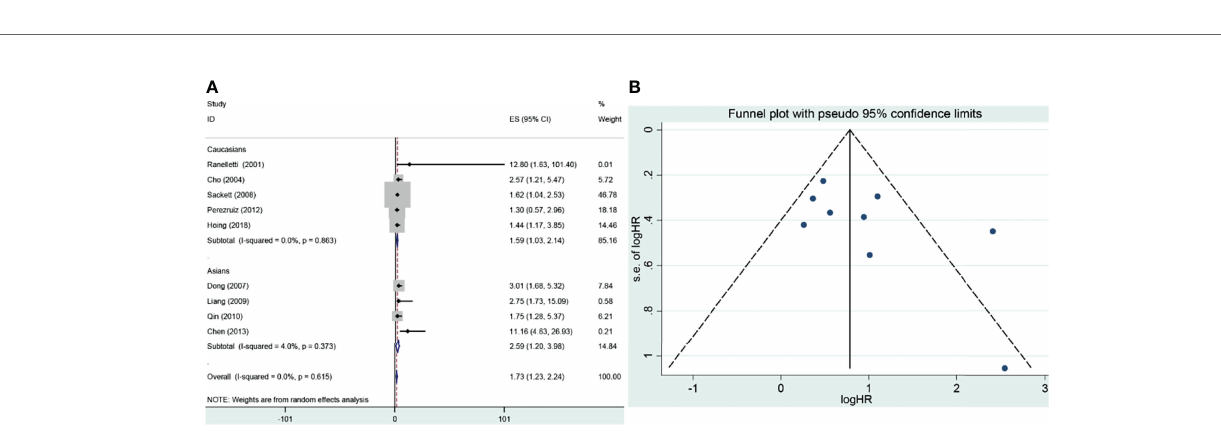
FIGURE 4 | Forest plot and funnel plot of the association between COX-2 expression and overall survival of laryngeal cancer. (A) Forest plot for laryngeal cancer. (B) Funnel plot for laryngeal cancer. HR, hazard ratio; CI, con fi dence